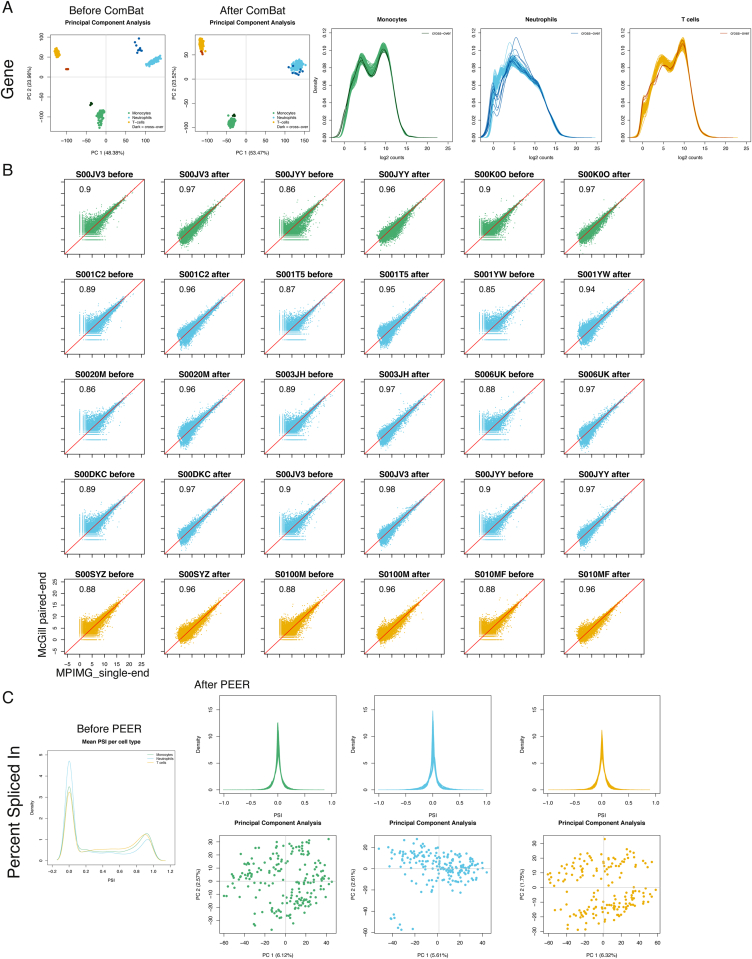
RNA-Seq Distribution and Batch Correction, Related to Figures 3 and 4(A) PCA before and after batch correction using ComBat in gene level. Darker color lines and dots represent cross-over samples from different sequence center. Distribution of normalized read counts (log2) in gene level in monocytes, neutrophils and naive CD4+ T cells.(B) Scatterplots of the pairwise correlation of gene quantification between crossover samples before and after batch correction.(C) Distribution of before and after PEER corrected PSI values (upper panel) and PCA plots (lower panel) in monocytes, neutrophils and naive CD4+ T cell.